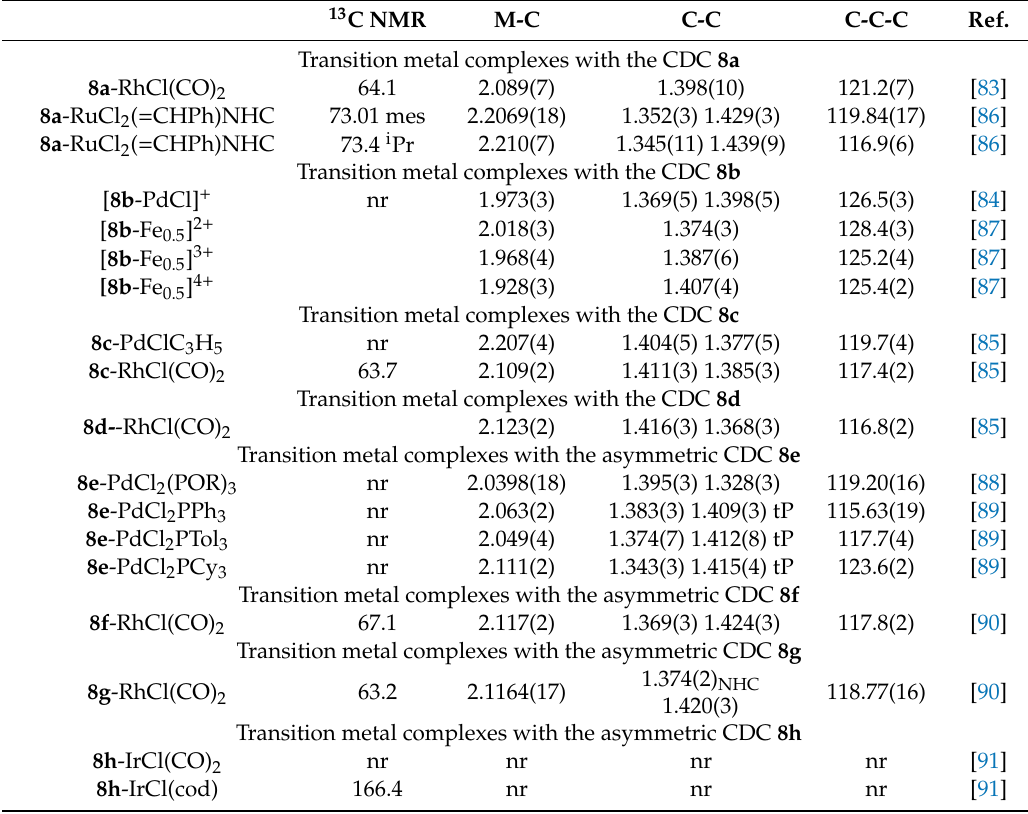
Figure 10. Symmetrical CDCs from which transition metal complexes are known. Table 8. Collection of transition metal complexes with the CDCs 8a – 8h . 13 C NMR shifts of the central carbon atom (in ppm).